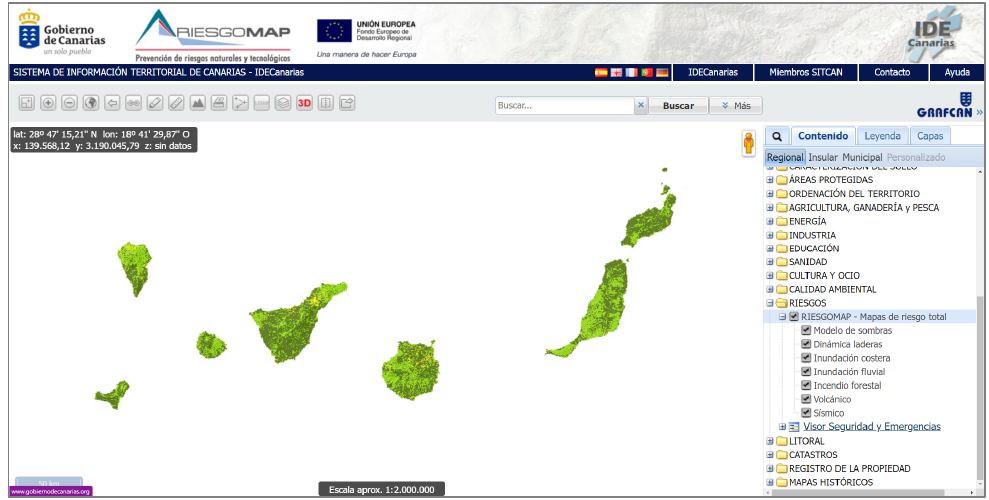
Figure A6. Overview of the resource. Source: GRAFCAN (2022b). Questions for reflection and reinforcement of concepts: a. Selecting the risk layer included in the left side menu, click on your area of residence, or any space of interest, and analyze the risk